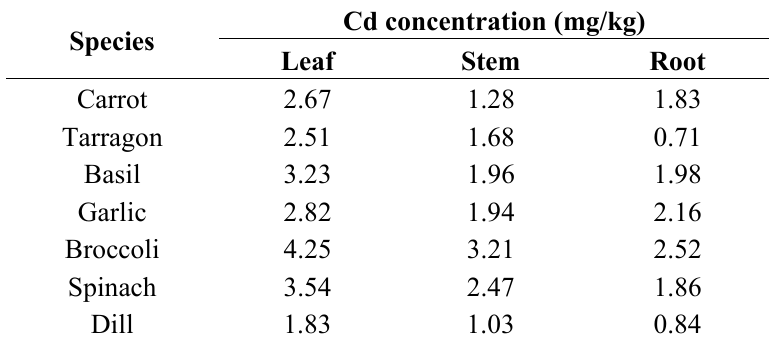
Table 7. Average cadmium (Cd) concentrations for the studied dried plants.